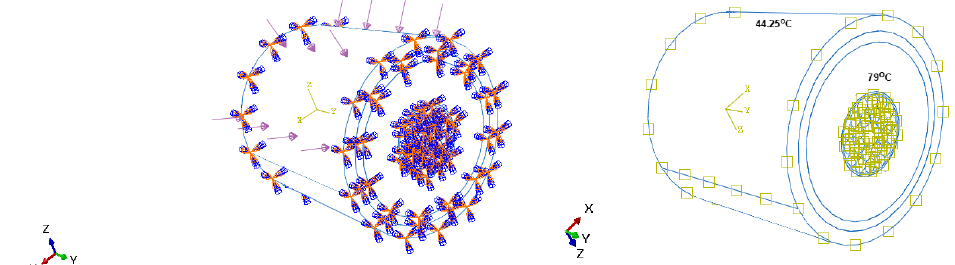
Figure 4. Mechanical and thermal boundary conditions considered in the